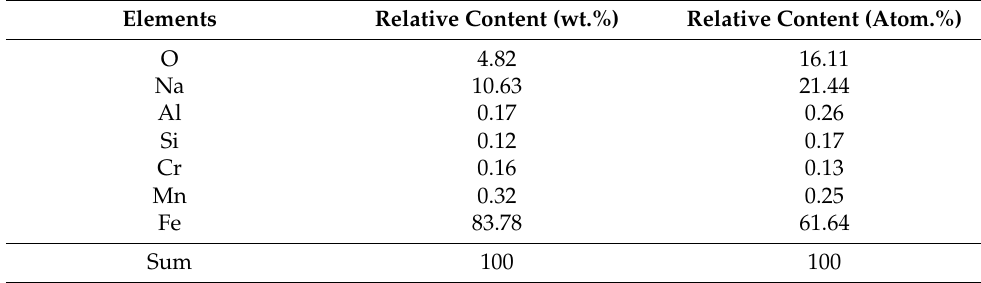
Figure 5. Elemental distribution ( a ) of the obtained catalyst nanoparticles surface and image ( b ) of surface fragment. Table 1. The mass and atomic content of elements.